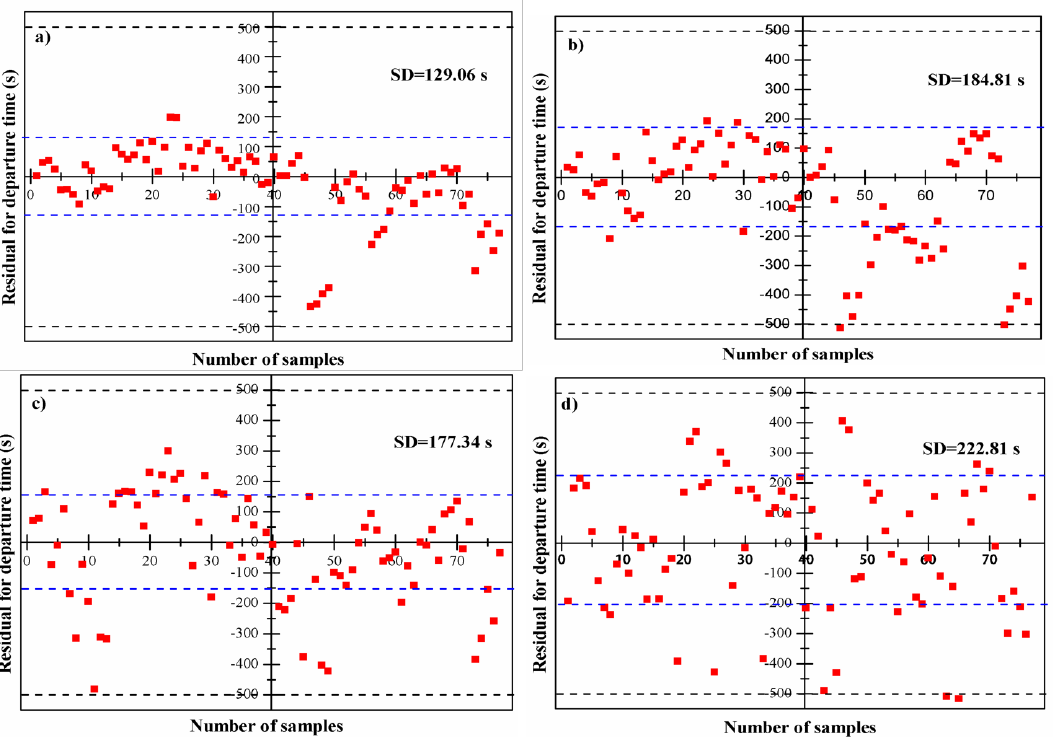
Figure 7. Residual for departure time at different points ( N = 77) under the situation where the starting points of exponential decline period are estimated by statistical analysis: ( a ) one-third point, ( b ) one-half point, ( c ) two-thirds point, and ( d ) three-fourths point. (A total of 30 points with large deviations (>515 s) were